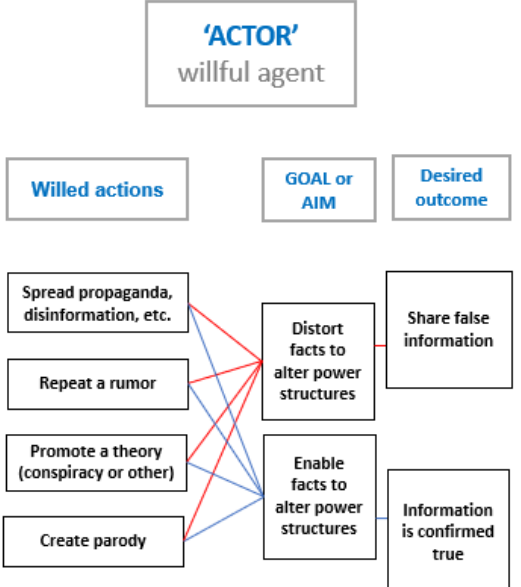
Figure 2. Detail of fake news model showing ‘actor’ side of the duality, including willed actions, goals, desired outcomes of creating fake news. Available at this url: http://scholarworks.csun.edu/handle/10211.3/218953, accessed on 6 July 2021. License: Attribution-ShareAlike 4.0 International (CC BY-SA 4.0)].